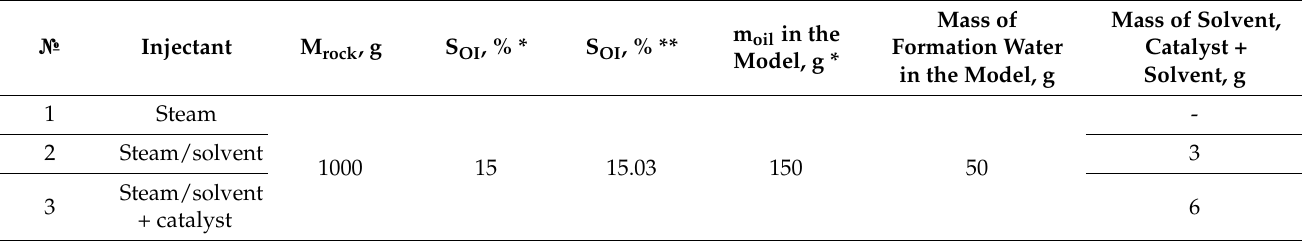
Table 6. Composition of the model of